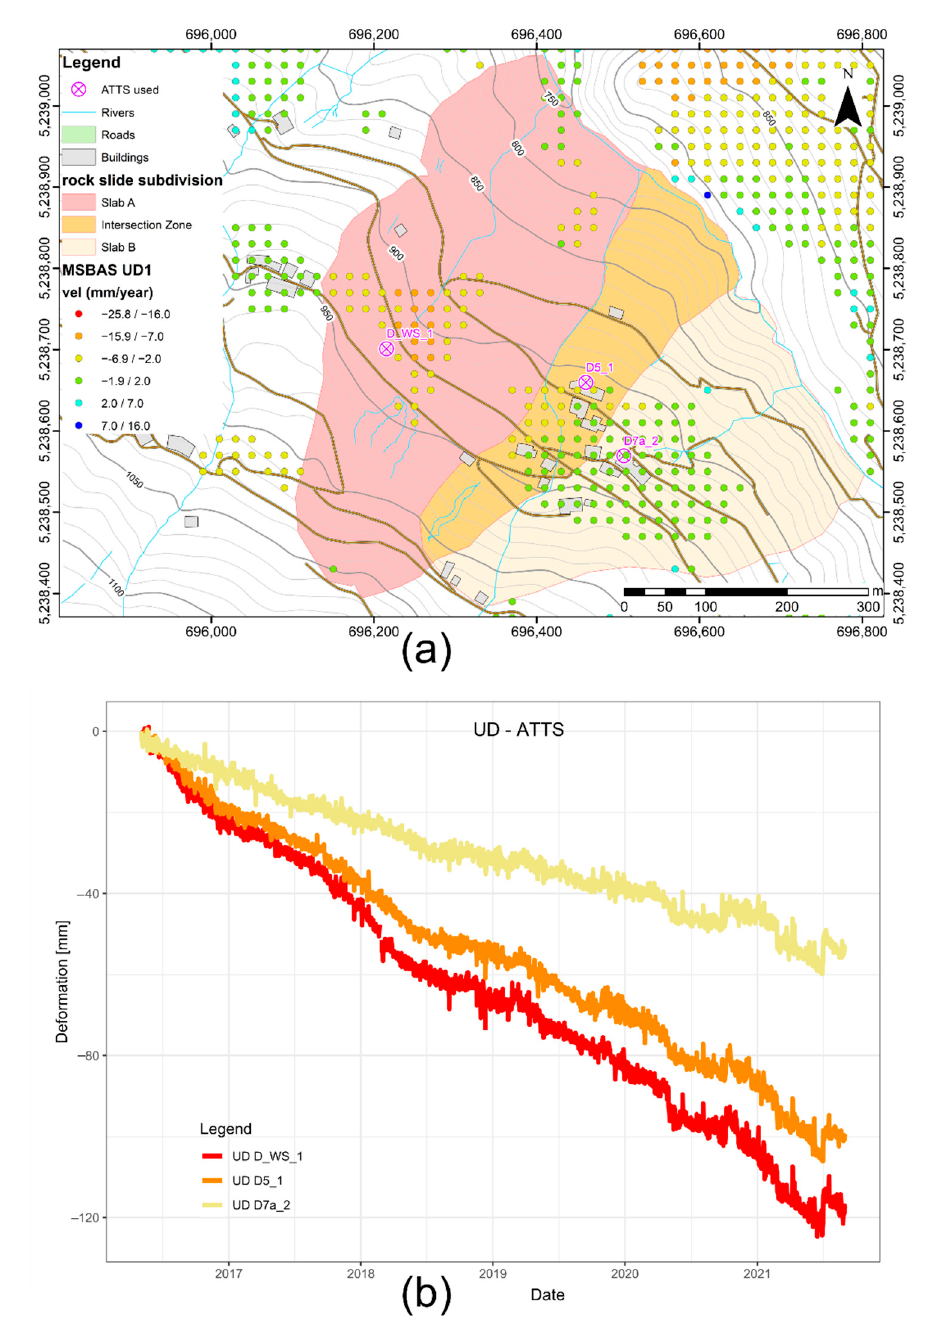
Figure 5. MSBAS velocities ( a ) and ATTS time series ( b ) for the Up-Down (UD) direction of motion at the Vögelsberg landslide.